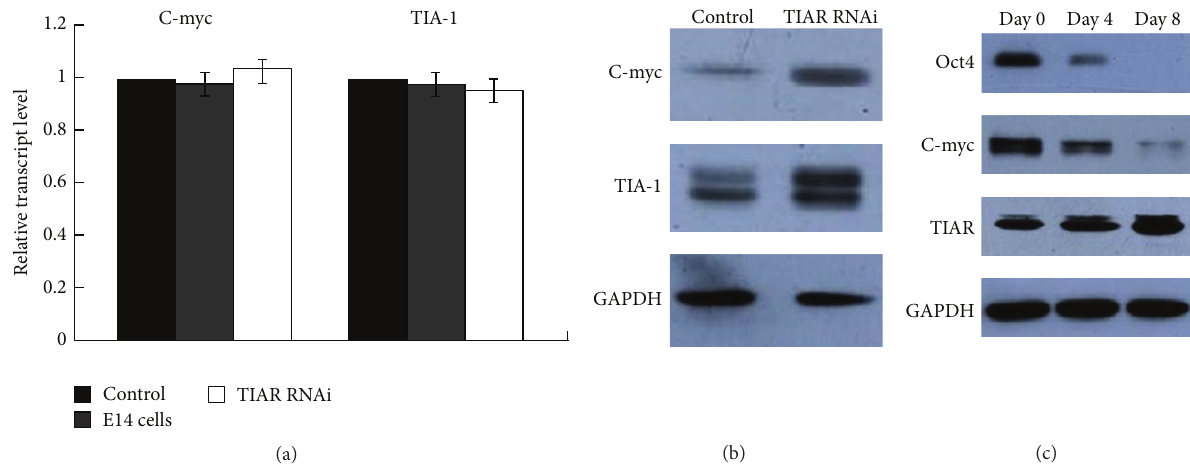
Figure 3: Downregulation of TIAR protein levels stimulates the expression of c-myc and TIA-1 in E14 cells. (a) Quantitative RT-PCR analysis of the gene expression of c-myc and TIA-1 in TIAR RNAi E14 cells and pSIREN-RetroQ control E14 cells. E14 cells were used as a control. (b) Western blot analysis of the gene expression of c-myc and TIA-1 in TIAR RNAi E14 cells and pSIREN-RetroQ control E14 cells. (c) Western blot analysis of the gene expression of Oct4, c-myc, and TIAR in undifferentiated TIAR RNAi E14 cells (day 0) and differentiated cell of TIAR RNAi E14 cells (day 4 and day 8). Control: pSIREN-RetroQ control E14 cells; TIAR RNAi: TIAR RNAi E14 cells.